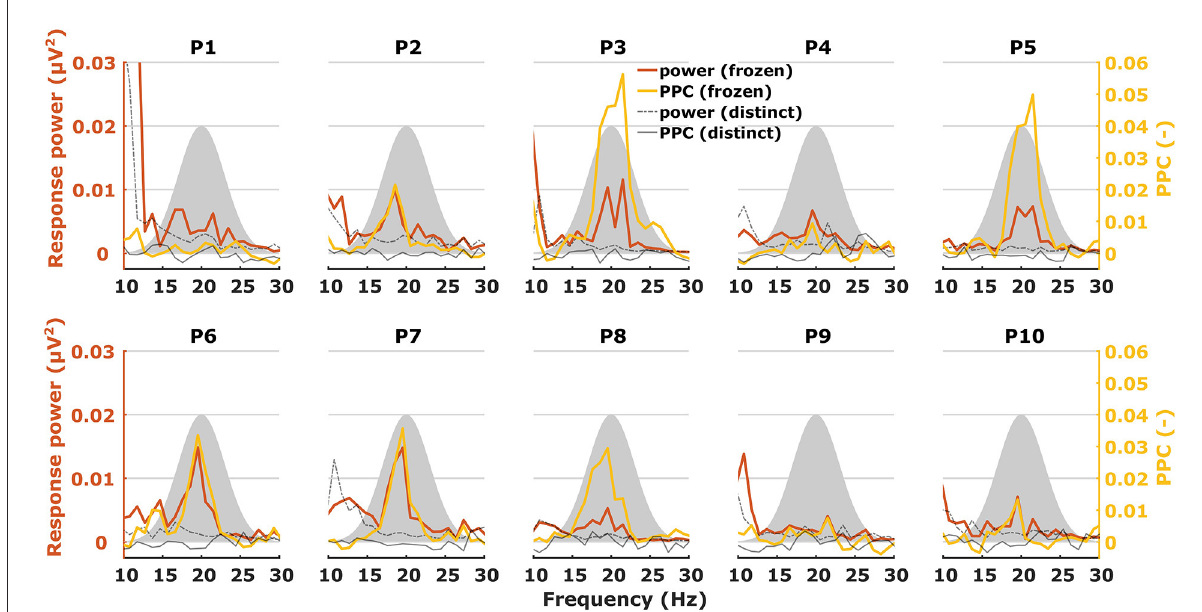
FIGURE7 Two different patterns, one of power (red) and one of PPC (yellow), plotted over each other across modulation frequency. The patterns are from TEMPEST phonemic-like responses in the left hemispheric channel for each participant. Black patterns describe the baseline from distinct responses. The shaded Gaussian curve represents the modulation frequency distribution of the stimuli (scaled arbitrarily).